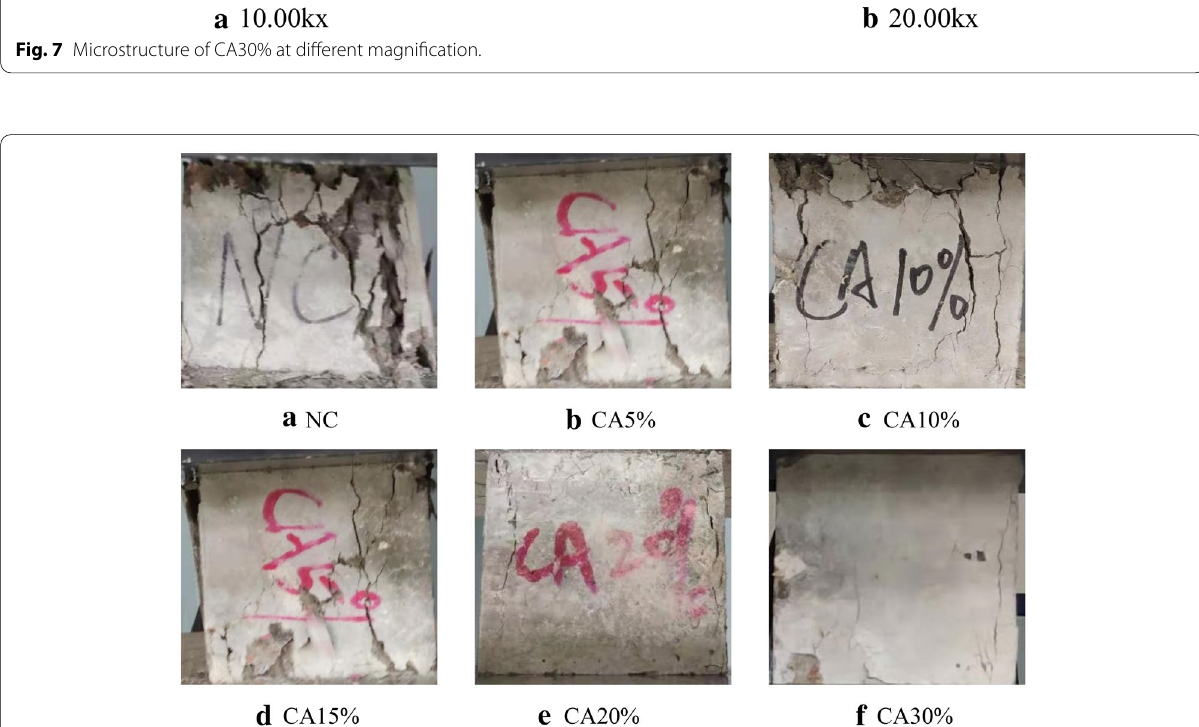
Fig. 8 Typical compression failure